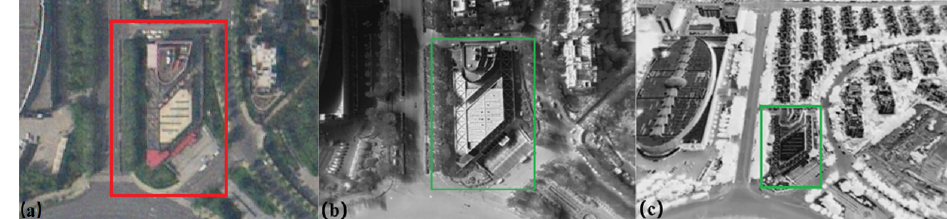
Figure 10. RGB-IR image pairs from our test dataset. ( a ) is a visible reference image with the target scene obtained from Google Earth. ( b , c ) are the infrared images with the target scene captured at different